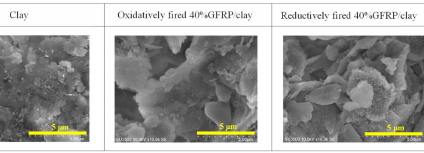
Figure 4. SEM images of the surface structures of clay and GFRP/clay ceramic samples.